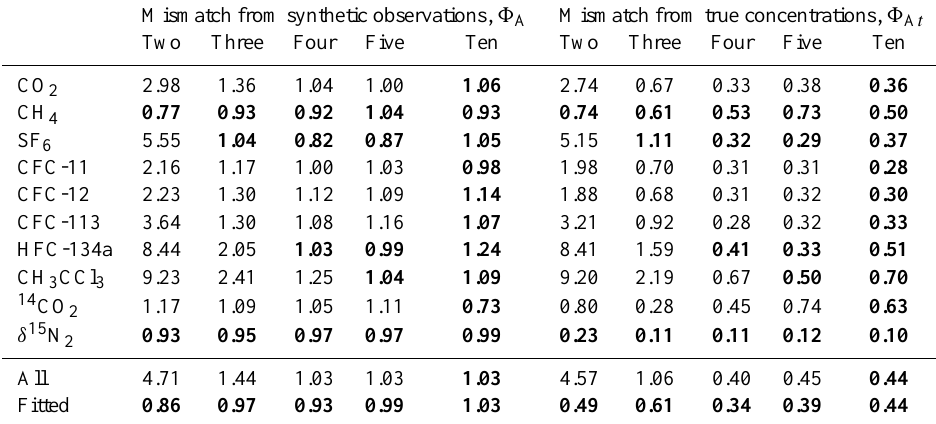
Table 3. Weighted RMS mismatch of modelled concentrations from Synthetic A observations and from the true concentrations for each tracer for each of the five Subsets in Table 2. Modelled concentrations are for the case with lowest 8 for each experiment. Numbers in bold are for tracers that were fitted for that particular Subset. As well as RMS mismatch for each tracer, we also show the RMS mismatch for all ten tracers together (All), and the RMS mismatch for only those tracers that were fitted in that experiment (Fitted). The true solution corresponds to the 8 A = 1 . 0 and 8 A t = 0 . 0. Mismatch from synthetic observations, 8 A Mismatch from true concentrations, 8 A